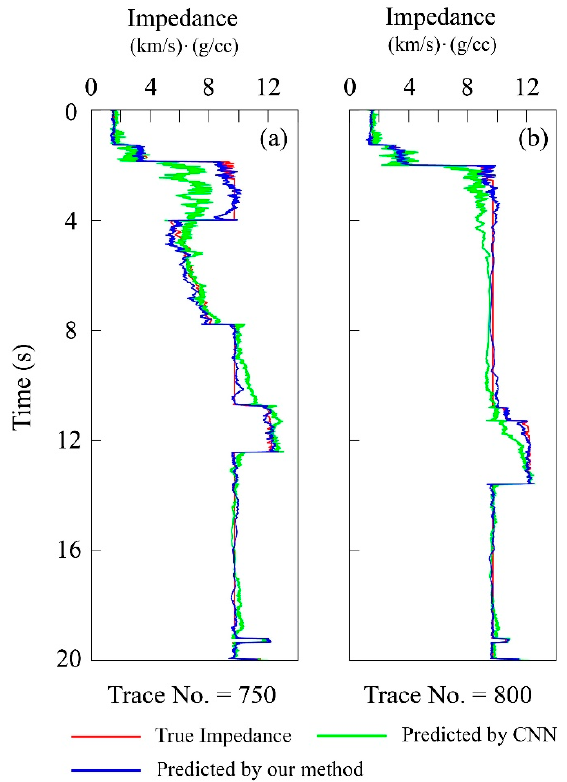
Figure 8. Impedance of the selected representative traces. ( a ) Trace number: 750; ( b ) Trace number: 800. Table 2. Performance metrics of our method on a section of SEAM model compared with that of the state-of-the-art deep learning inversion methods.